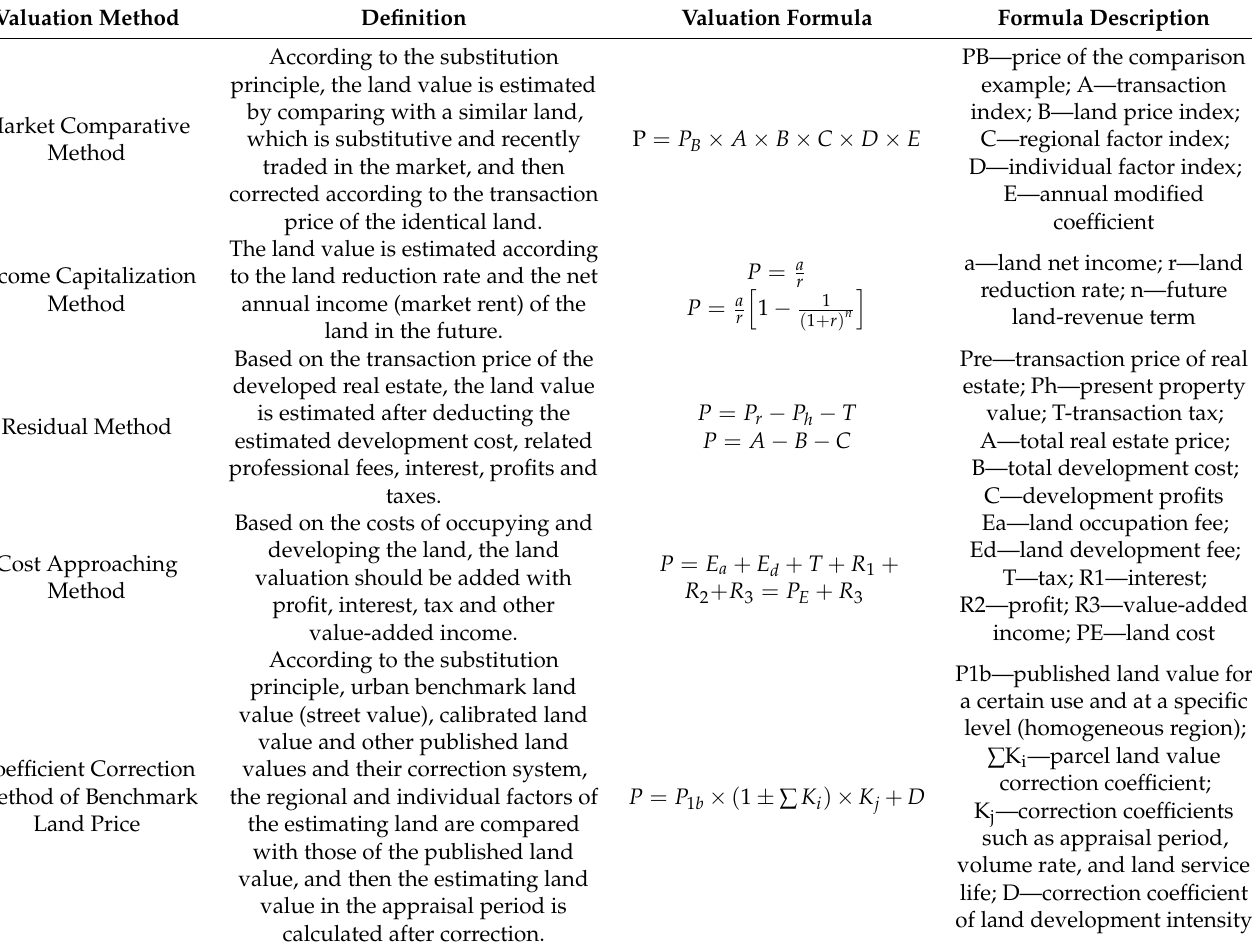
Table 1. Major valuation methods for construction